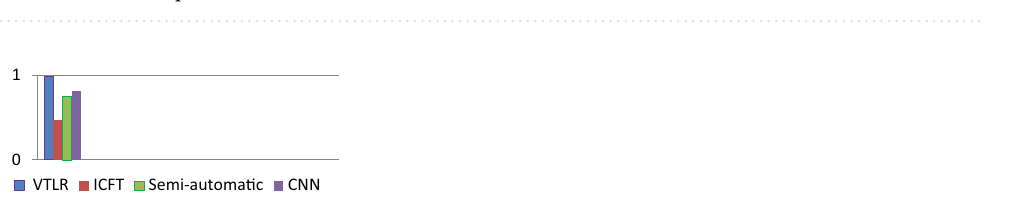
Table 4. Simulation parameters and values.